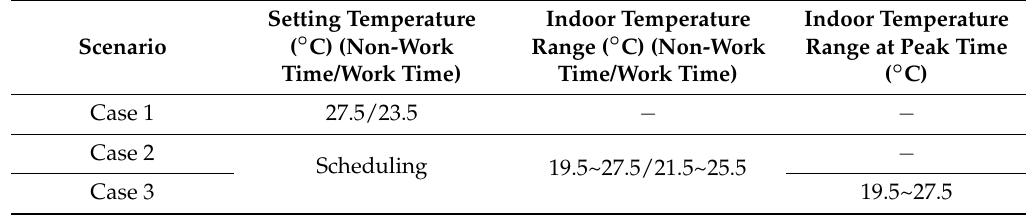
Table 2. Scenarios for the heating, ventilation, and air-conditioning (HVAC) system simulation.